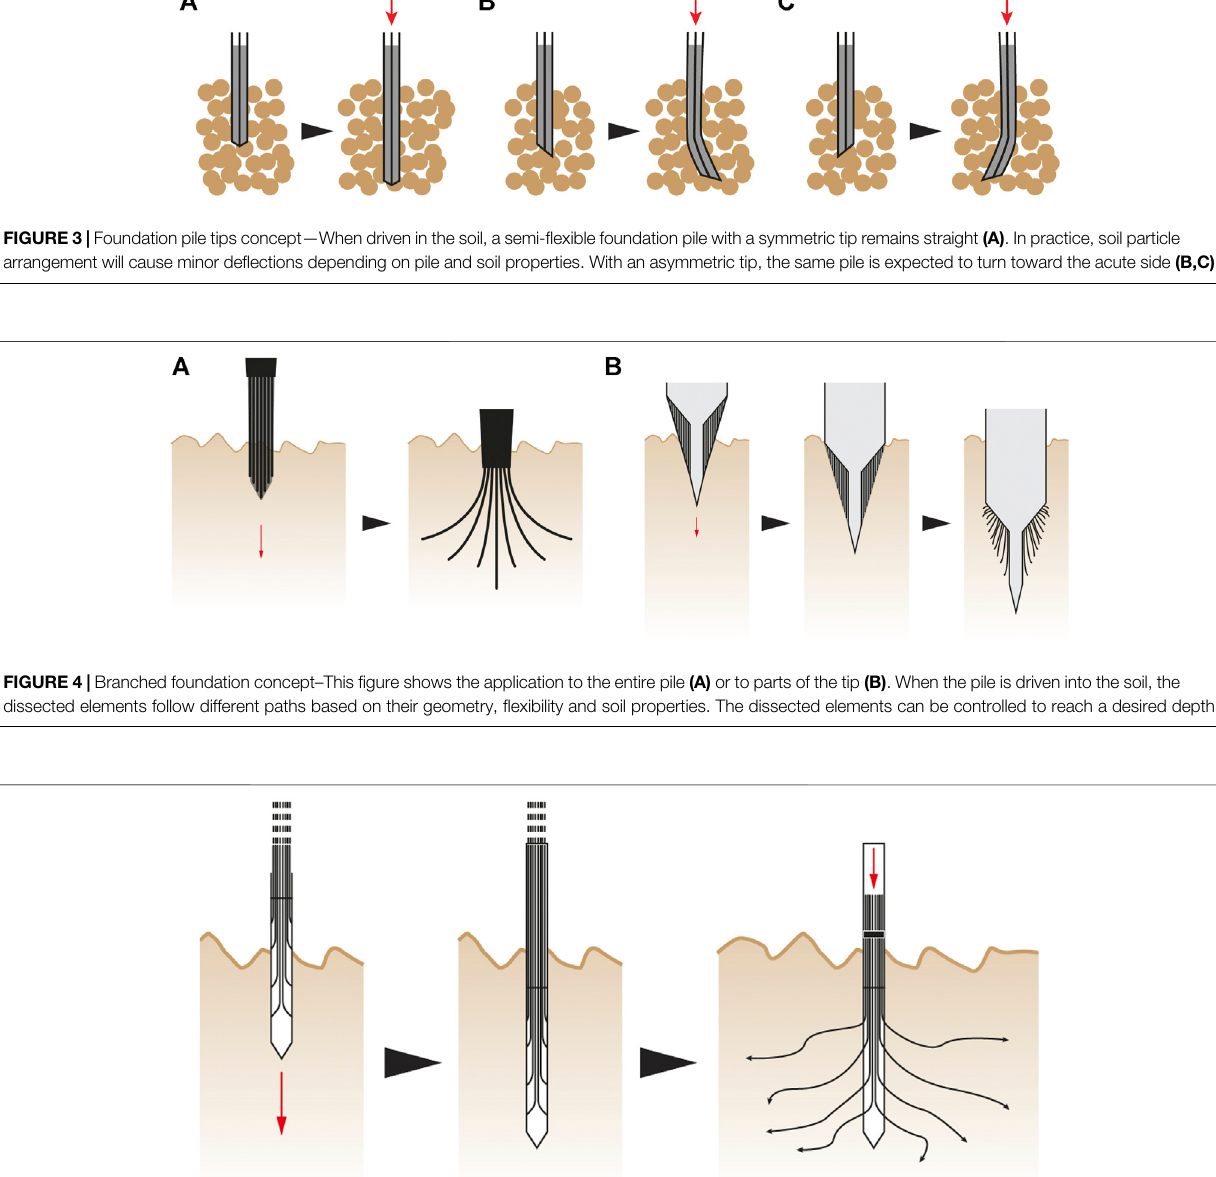
Frontiers in Robotics and AI |